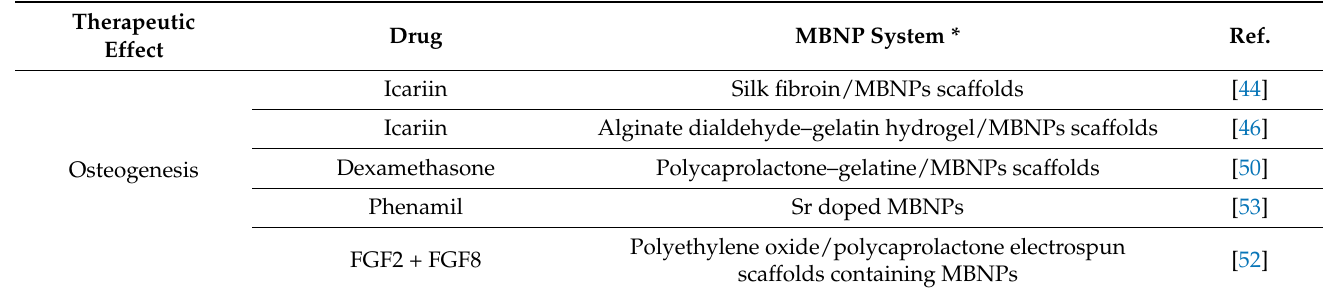
Table 2. Drug delivery systems based on mesoporous bioactive